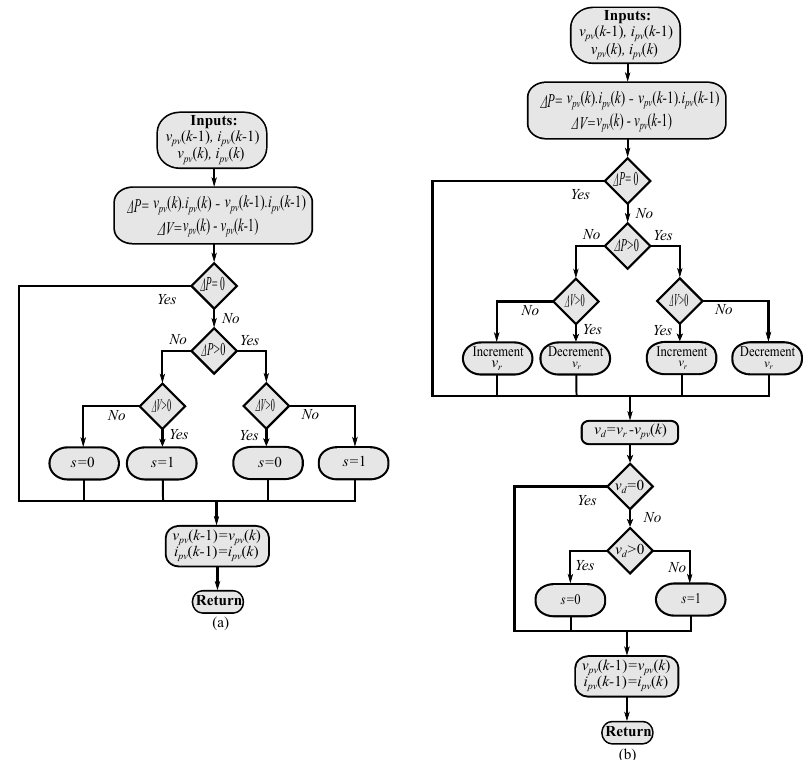
Figure 5. The proposed MPPT techniques: ( a ) MPPT-based direct P&O. ( b ) MPPT-based indirect